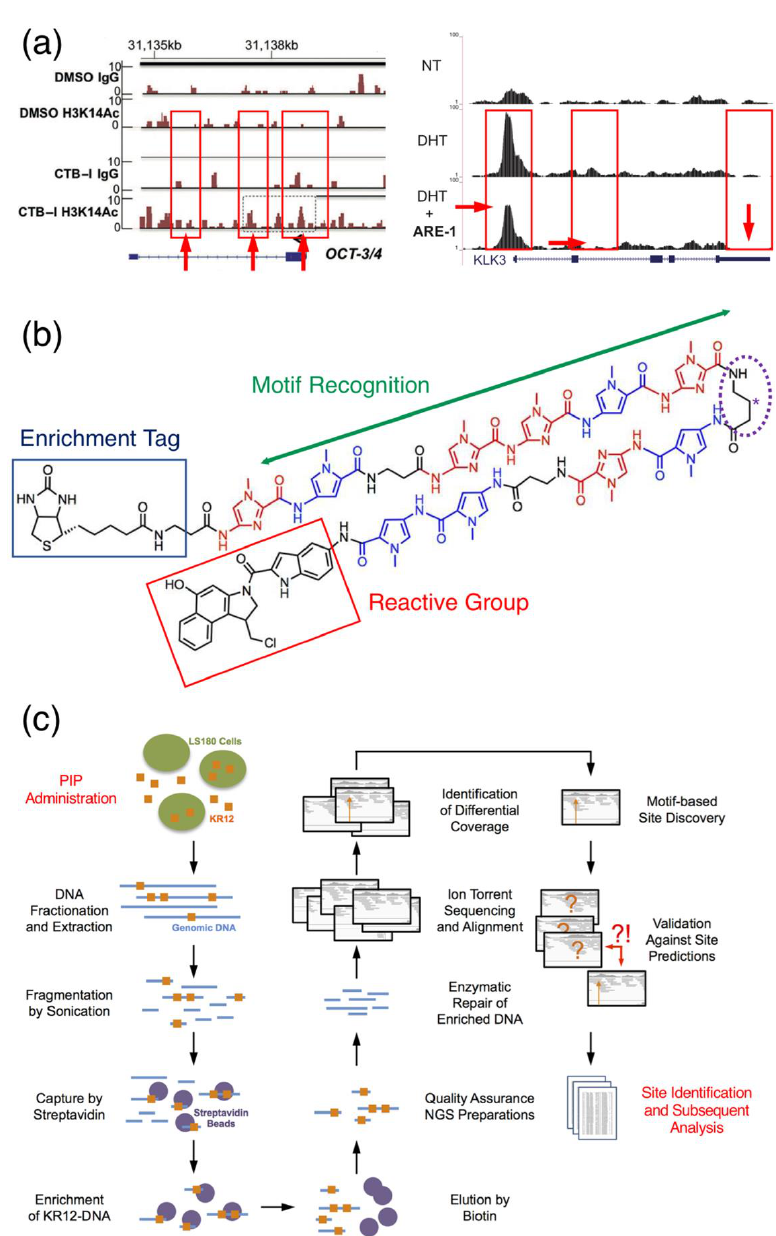
Figure 5. Sequencing with PIPs. ( a ) Examples of PIP-assisted ChIP-seq experiments using a CTB, a histone acetyltransferase activator, conjugated PIP in conjunction with ChIP-seq to detect changes in H3K14Ac activity in the promoter region of OCT-3/ 4 (left); another example of coupling dihydrotestosterone (DHT) with a PIP targeting the androgen receptor gene ( AR ) to evaluate changes in the genomic occupancy of AR in the promoter region of KLK3 is provided on the right. NT indicates no treatment. Loss, gain or changes in amplitude of the local reads (red arrows and box with solid outlines) are then used to infer PIP genomic interference. Reproduced from [21], © 2015 Wiley (left) and [30], © 2019 Oxford University Press under the license terms of CC BY (right). ( b ) Scheme of a possible configuration of biotinylated PIPs for Chem-seq applications. In these situations, biotin is used as the enrichment tag (solid blue outline), and indole- seco -CBI (solid red outline) is the reactive alkylating moiety. The polyamide backbone provides a mean for the molecule to recognize and bind the minor groove of specific genomic DNA sites. Placement of the biotin enrichment tag at the hairpin turn (dotted purple outline labeled with asterisk) has also been proposed and tested [70]. ( c ) A representative Chem-seq workflow utilizing a bifunctionally conjugated PIP (see Figure 4b) to alkylate and enrich genomic-binding sites. Images for ( b , c ) were adapted from [65] by the author, © 2019 under the license terms of CC